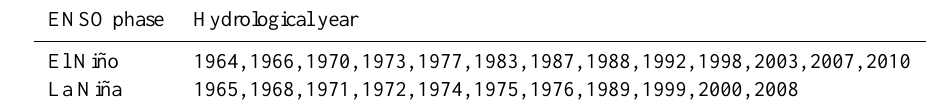
Table 1. Hydrological years that fall under the El Niño and La Niña phase. Other years are classified as ENSO neutral.